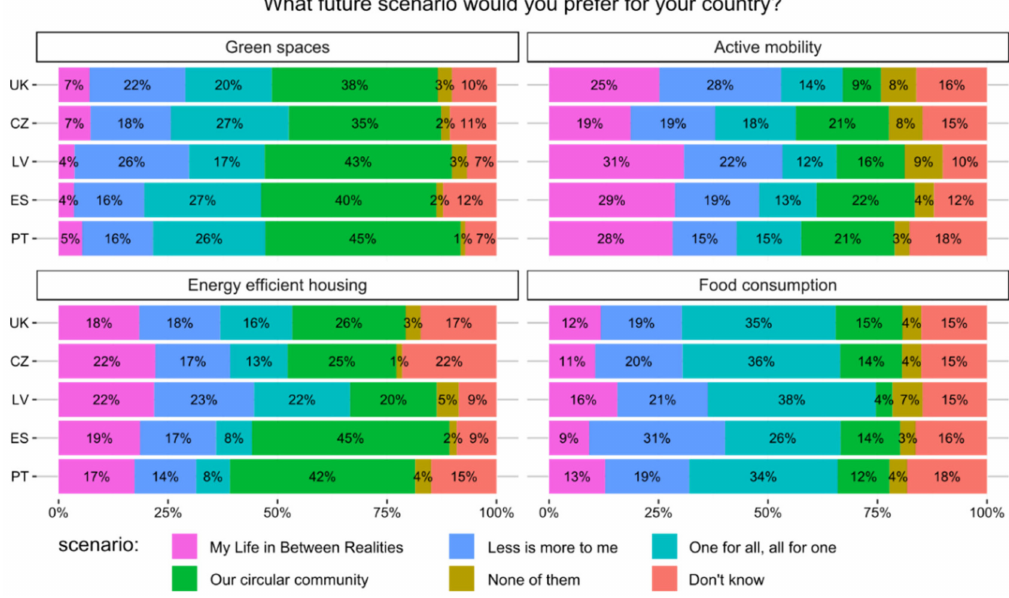
Figure 3. The most preferred scenarios in the domains of green spaces, active mobility, energy e ffi cient housing, and food consumption (in percentages of respondents from the United Kingdom, Czech Republic, Latvia, Spain, and